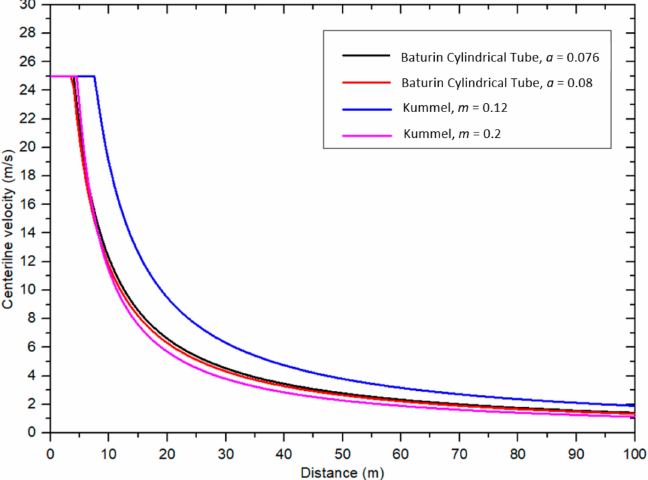
Figure 2. Jet fan centerline velocity.